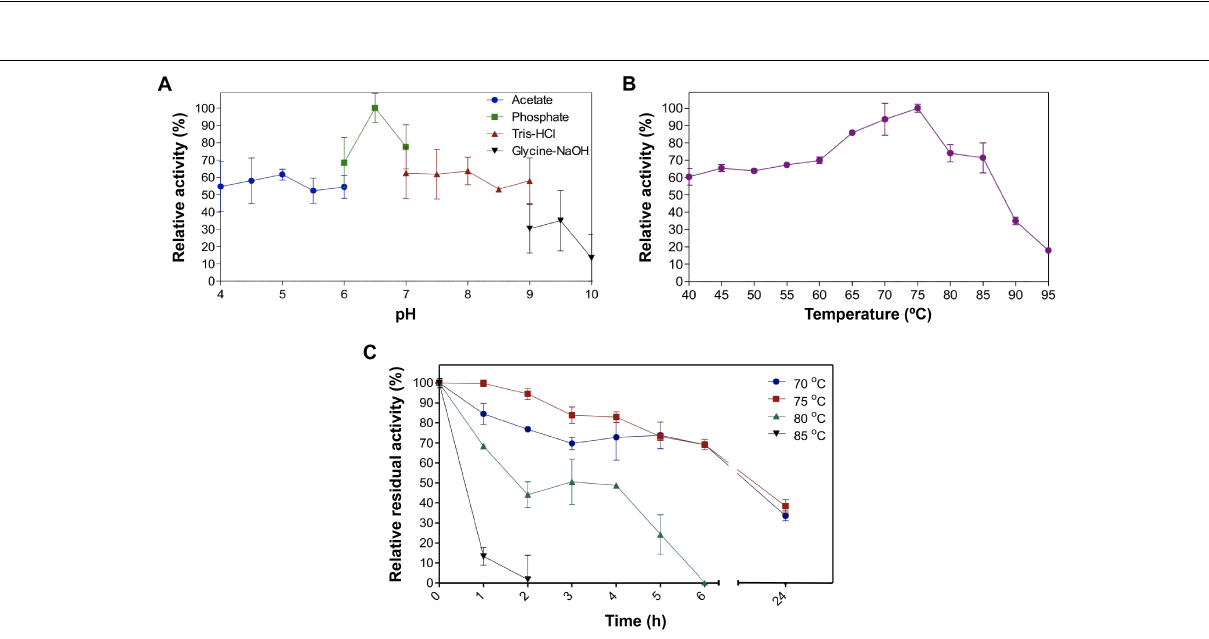
FIGURE 5 | Confirmation of EstDZ4 esterolytic activity. (A) Detection of EstDZ4 esterolytic activity via native PAGE analysis and Fast Red staining using 1-naphthyl acetate as a substrate. L1, clarified lysate of cells overexpressing estDZ4; L2, clarified lysate of cells carrying an empty vector. (B) Substrate profiling of the esterolytic activity of EstDZ4, using purified enzyme. The relative enzymic activity was measured as released pNP at 410 nm (pH 7, 40 ◦ C). The reported values correspond to the mean value of three independent experiments performed in triplicate and the error bars to one standard deviation from the mean value. Assaying the esterolytic activity of EstDZ4 within the pH range of 4–10 at 40 ◦ C using pNP-octanoate as the substrate, revealed that the optimal pH for the new enzyme is pH 6.5 ( Figure 6A ). Measurements of its relative catalytic activity at different temperatures, on the other hand, showed that EstDZ4 has a broad temperature range of action as it retains high levels of esterolytic activity at temperatures between 40–85 ◦ C, with its optimal temperature of action being at 75 ◦ C ( Figure 6B ). In order to evaluate the thermostability of EstDZ4, the enzyme was incubated for prolonged time periods in high temperatures and its residual activity was measured. As shown in Figure 6C , EstDZ4 exhibited a half-life of ∼ 5 h when exposed to 80 ◦ C, and even after 24 h of incubation at 70 and 75 ◦ C, the enzyme retained more than 40% of its initial activity, demonstrating that EstDZ4 is a highly thermostable esterase.